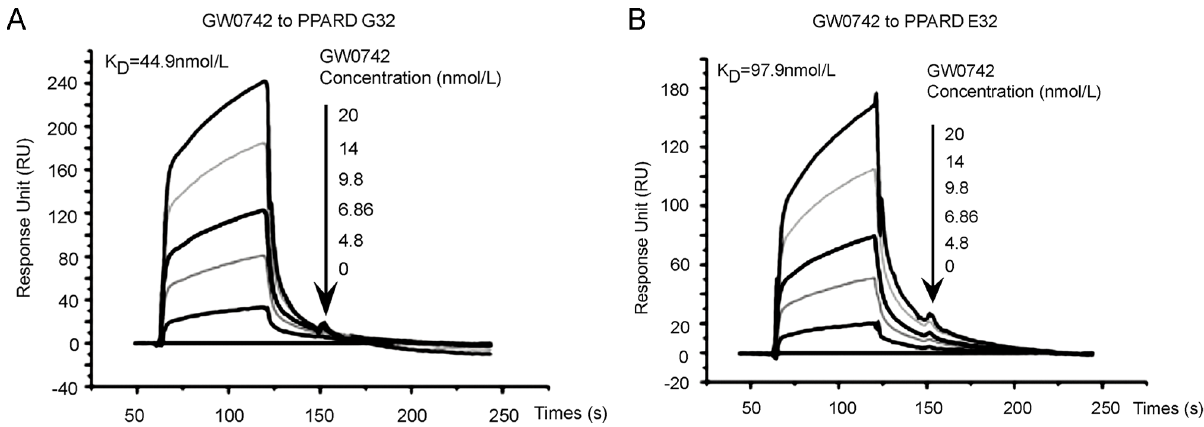
Figure 3. The G32E substitution does not alter the binding affinity of sPPARD with ligand. The surface plasmon resonance analysis was performed, and the sensorgrams were obtained from injection of GW0742 at 5 concentrations over surface-immobilized wild-type sPPARD (G32, A) or G32E mutant (E32, B). GW0742 were injected for 60 s, and dissociation was monitored for more than 120 s. The concentrations ( m mol/L) are shown next to the arrows. For the kinetic analysis, wild-type sPPARD and G32E mutants of five reference-subtracted sensorgram signals were globally fitted into a 1:1 interaction model [19], giving an association rate constant ( K a ), and a dissociation rate constant ( K d ). The equilibrium dissociation constant ( K D ) was calculated by the ratio of rate constant ( K d /K a ).